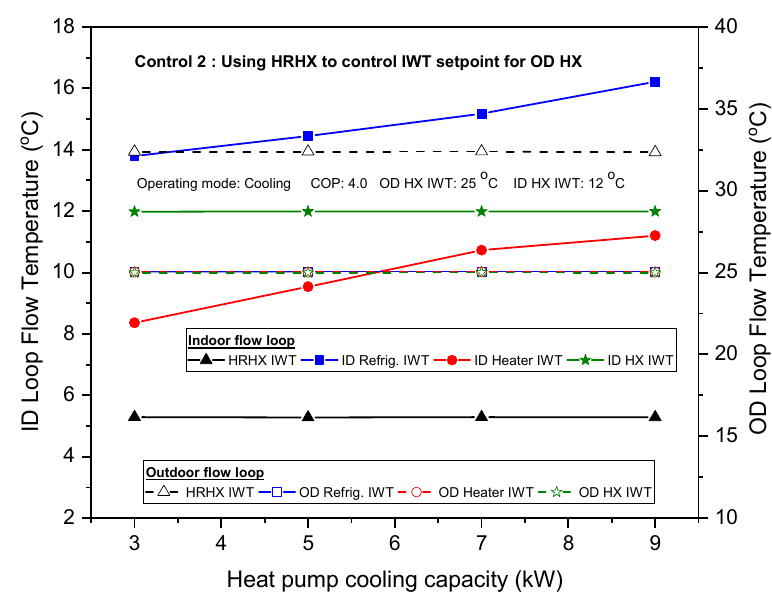
Figure 12. Flow loop temperature with variation in heat pump cooling capacity for control (2).